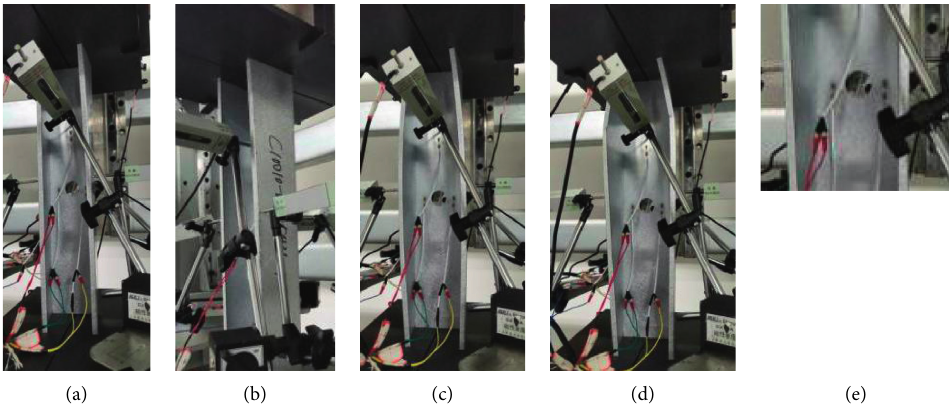
Figure 12: Buckling mode of specimen C10010-05-CH3-1. (a) Local buckling in the web. (b) Local buckling in the flange. (c) Distortional buckling. (d) Plastic crush. (e) Local buckling including holes.